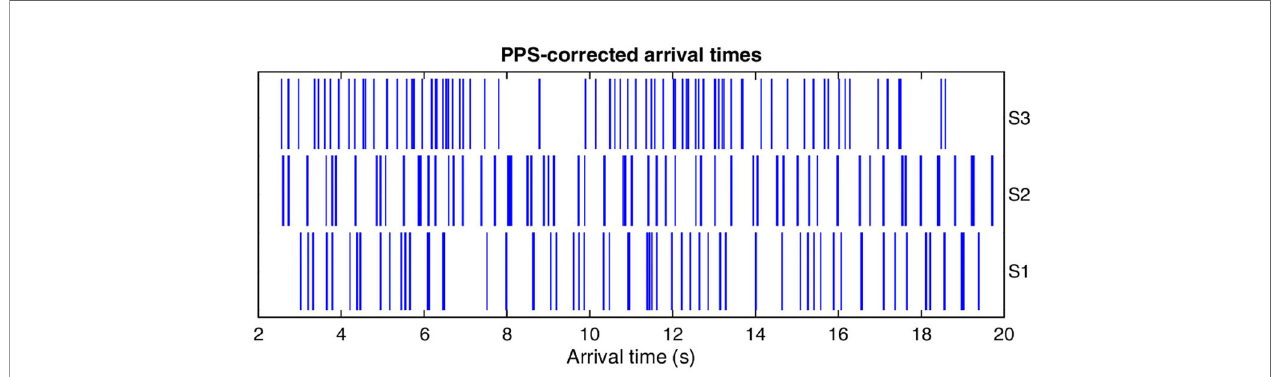
FIGURE 6 | Arrival patterns on 16 July 2021, at 16:03 after synchronization (PPS correction) of the recordings at the three hydrophones SWAN1, SWAN2